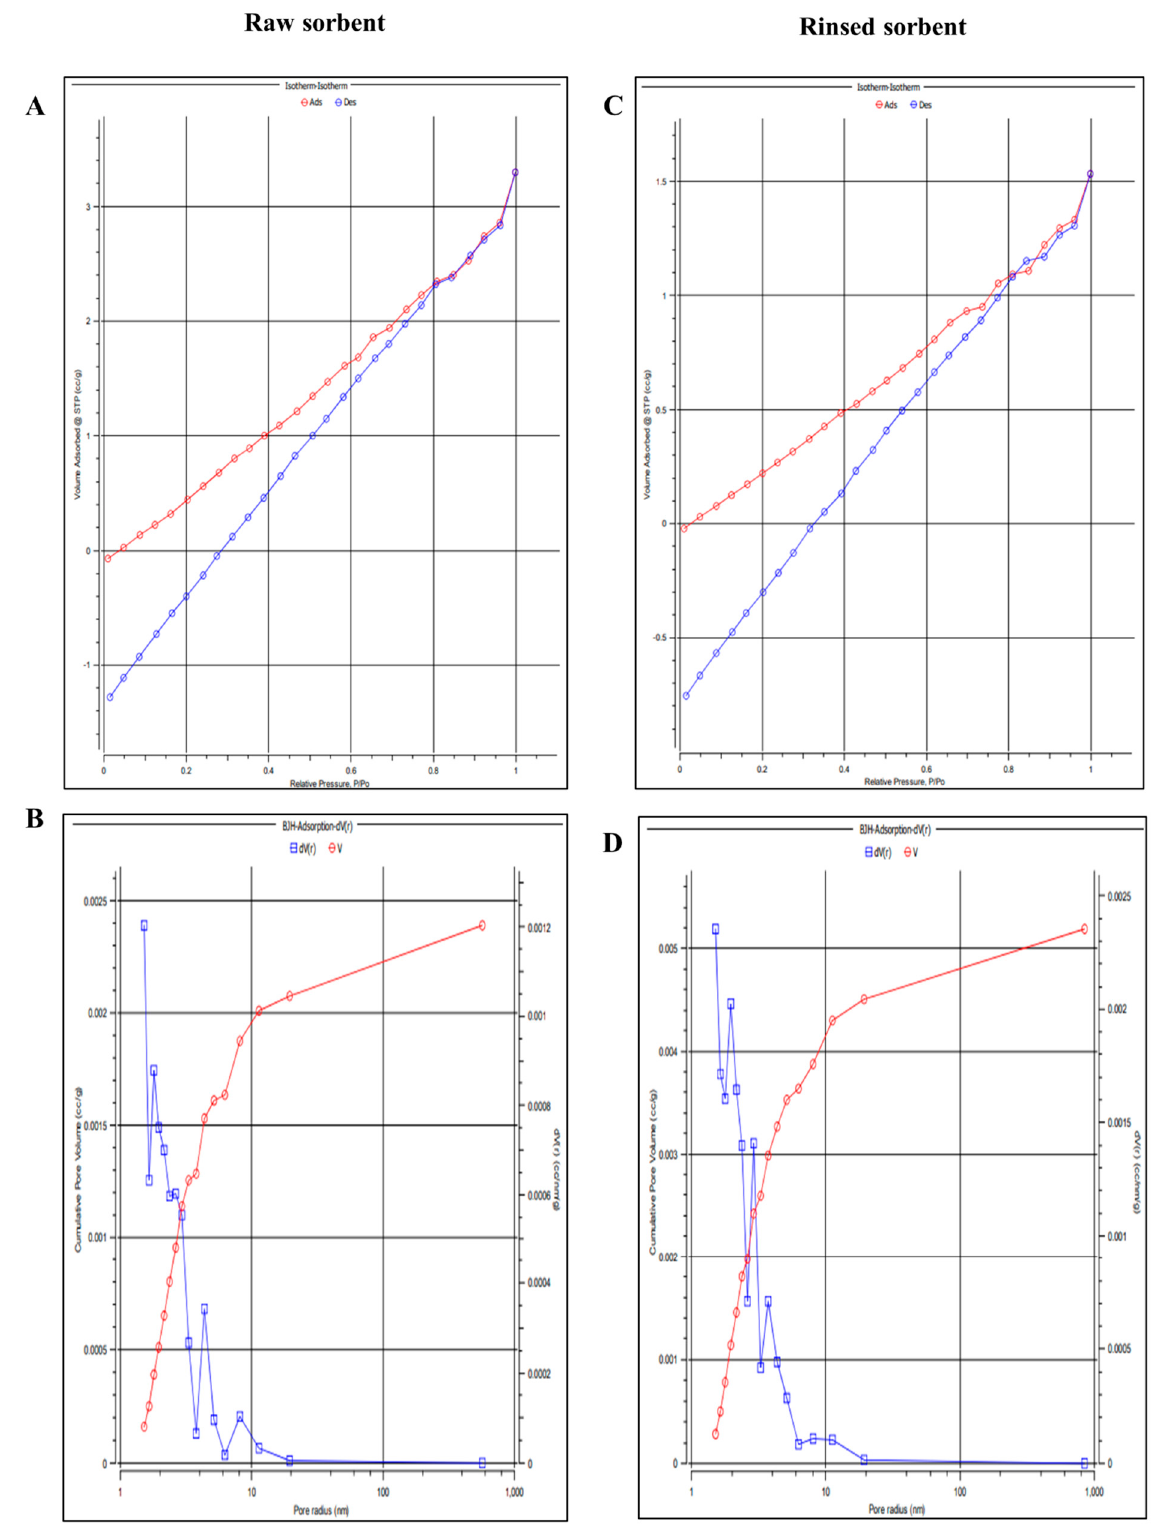
Figure 5. Characterization of the mesoporous structure of raw sorbent ( A , B ) and rinsed sorbent ( C , D ). BET isotherms of raw sorbent ( A ) and rinsed sorbent ( C ). Cumulative pore volume distribution of both ( B ) raw sorbent and ( D ) rinsed sorbent. The pore volume indicates the total volume of the pores at a specific diameter, in cc/g as evaluated from BET measurements.